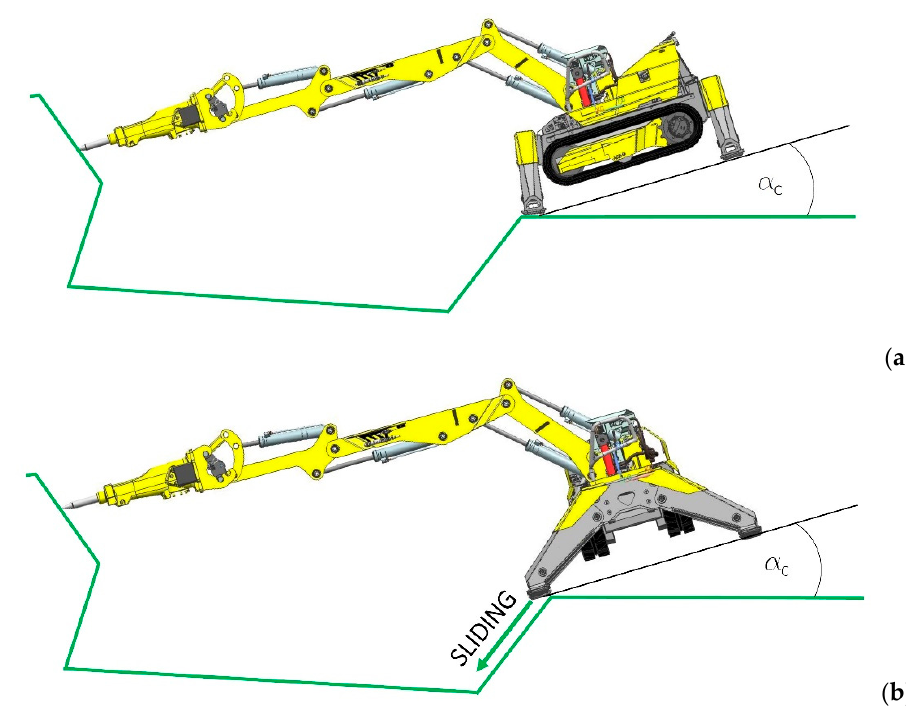
Figure 7. Critical tilting angle α C for two cases of robot positioning during operation: ( a ) robot with working arm longitudinal to undercarriage; ( b ) robot with working arm perpendicular to undercarriage, a case involving sliding.